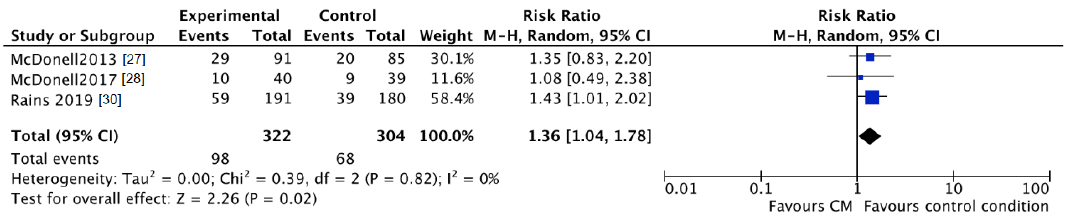
Figure 7. Forest plot of the comparison CM versus standard care after intervention, percentage of participants lost to